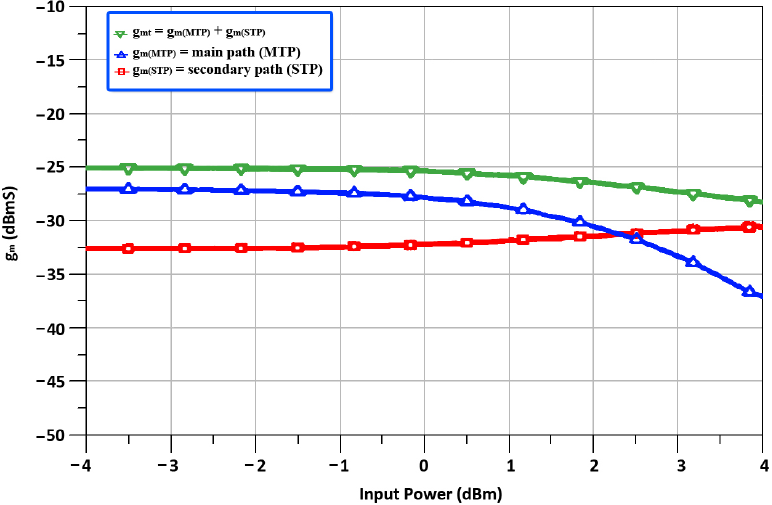
Figure 6. The transconductances of MTP ( g m total transconductances ( g m